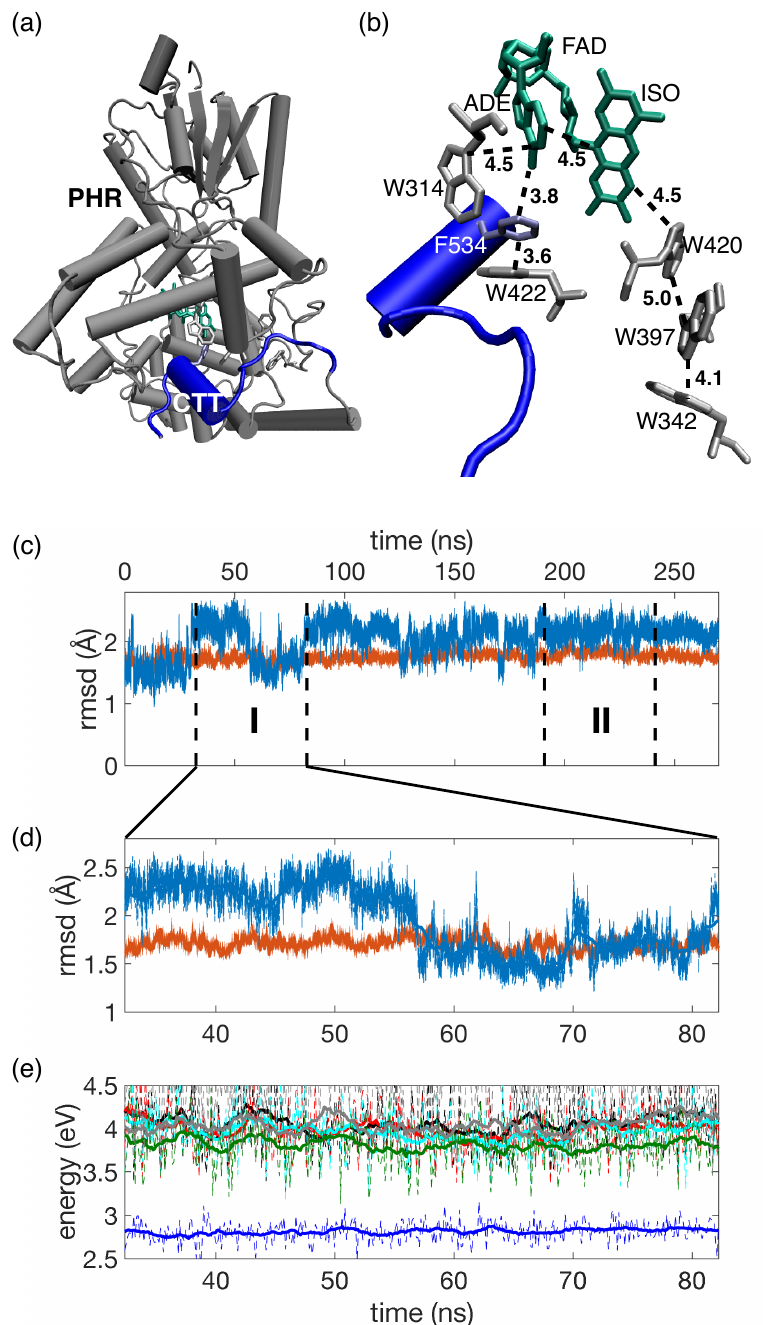
Figure 1. ( a ) Structure of Drosophila cryptochrome (dCRY), C-terminal tail (CTT) highlighted in blue (residues 520–539, PDB: 4GU5 [10]); ( b ) FAD cofactor and tryptophan residues W, edge-to-edge distances in Å; ( c ) root mean square displacements (RMSD) of dCRY (orange) and CTT (blue) of a 270 ns trajectory; I (32.4–82.8) ns and II (190.8–241.2) ns: considered time intervals in QM/MM simulations; ( d ) Zoom of RMSD during interval I; ( e ) Excitation energies of the FAD ππ ∗ state (blue) and CT states isoalloxazine (ISO) − W420 + (grey), ISO − W397 + (green), ISO − ADE + (red), ISO − W314 + (black) and ISO − W422 + (cyan) evaluated every 125 ps (dashed) on QM(TD-DFT(BNL/cc-pVDZ)/MM( ff14SB ) level (cf. Materials and Methods, Section 4.2) together with the 2.5 ns moving average